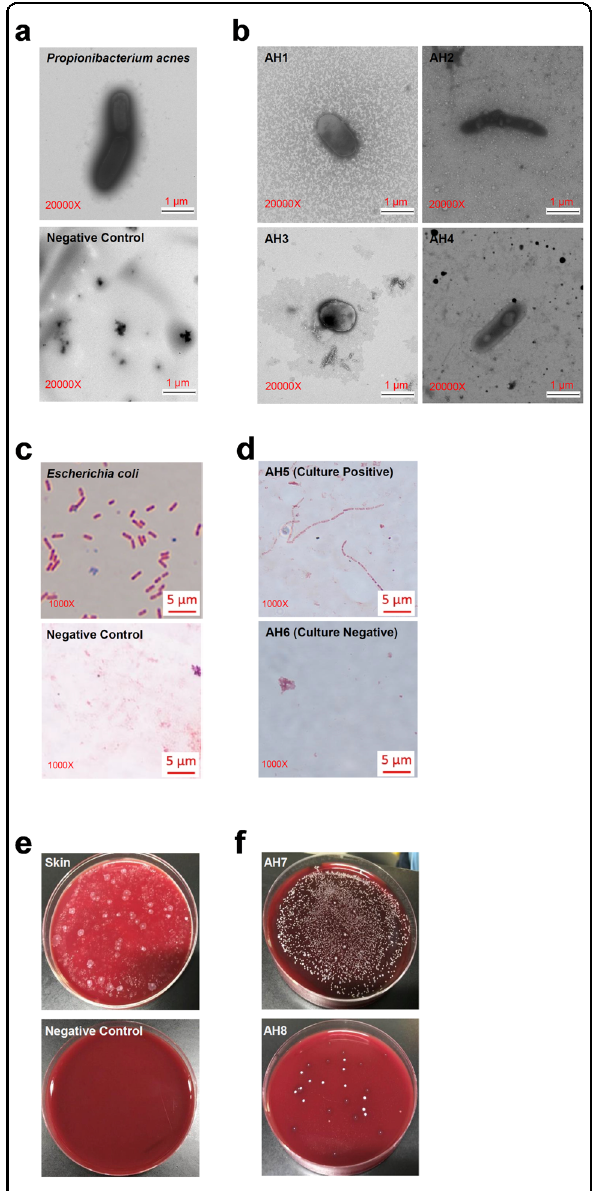
Fig. 2 Detection of intraocular bacteria in AH specimens and cultures. a Negative staining transmission electron microscopy was used to visualize cultured P. acnes at 20,000× magni fi cation. The negative control shows the visualization of water without AH specimen. b Negative staining transmission electron microscopy shows bacteria in minimally manipulated fresh AH specimens at 20,000× magni fi cation. c Cultured E. coli was visualized by light microscopy. The negative control consists of sample preparation buffer without any AH inoculation. d Bacteria in cultured AH samples (examples of culture-positive and -negative samples) were visualized by light microscopy. e Representative anaerobic cultures of skin specimens and negative controls (PBS solution used to dilute specimens). f Representative anaerobic cultures of AH